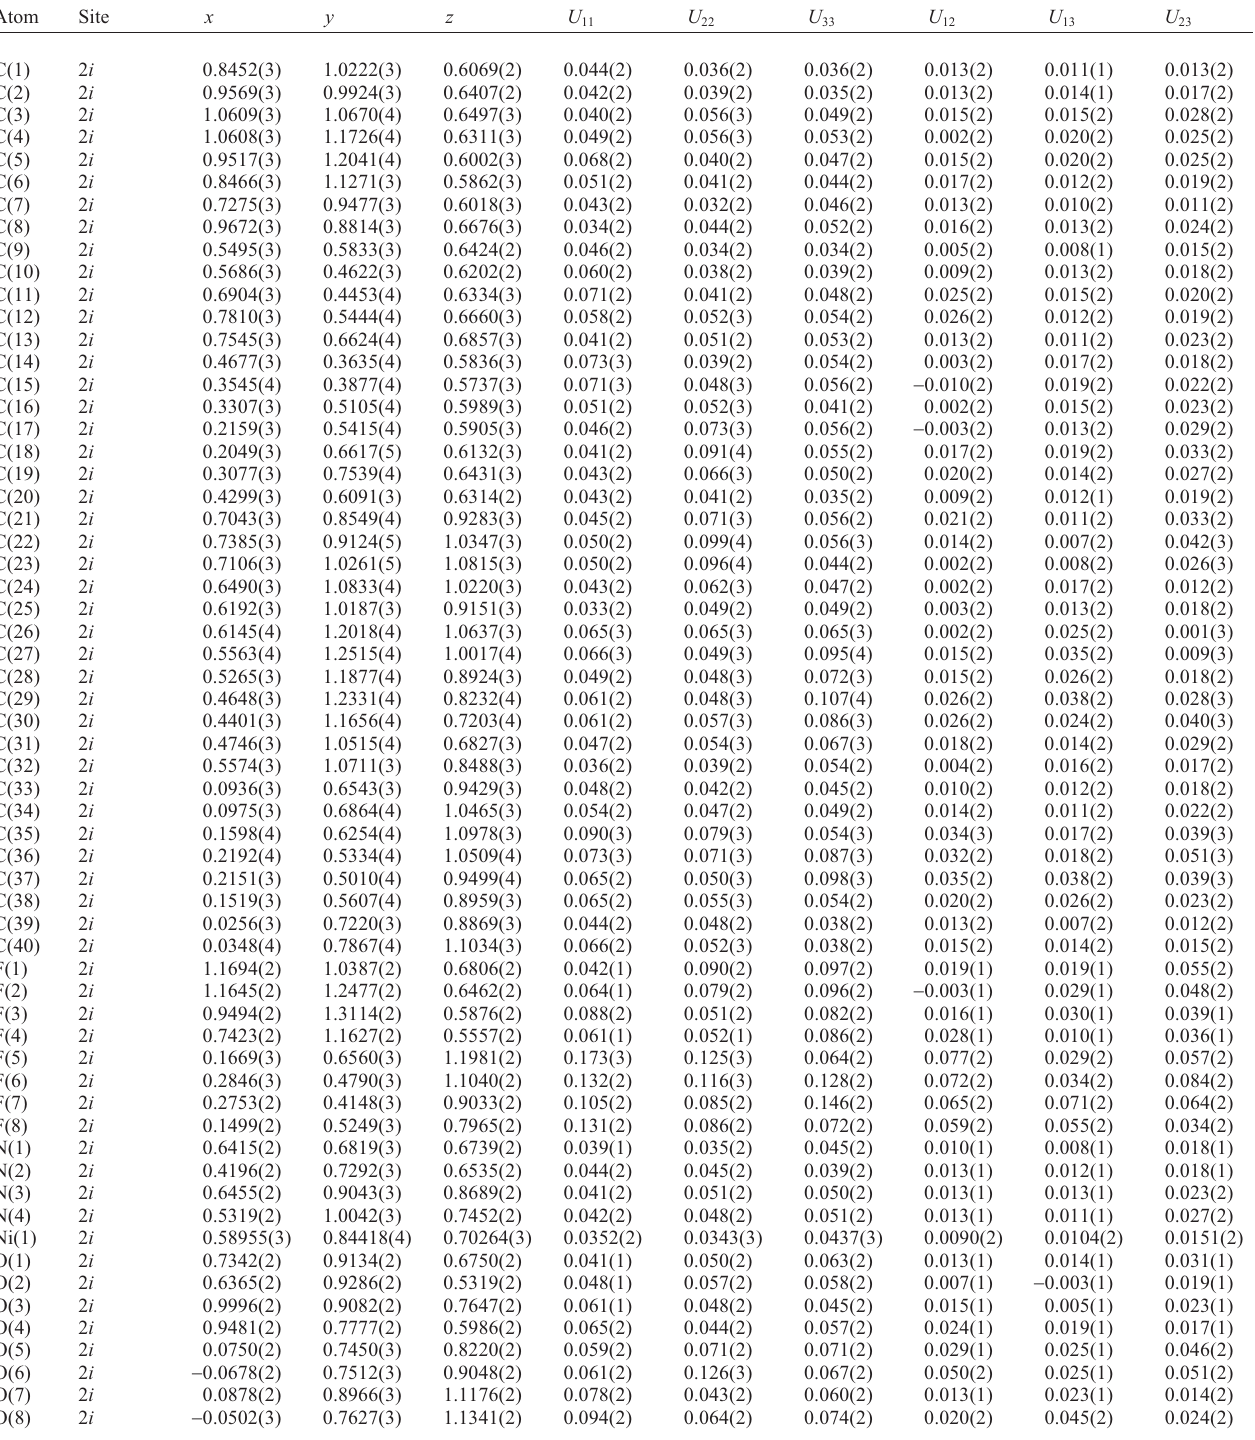
Table 3. Atomic coordinates and displacement parameters (in Å 2 )